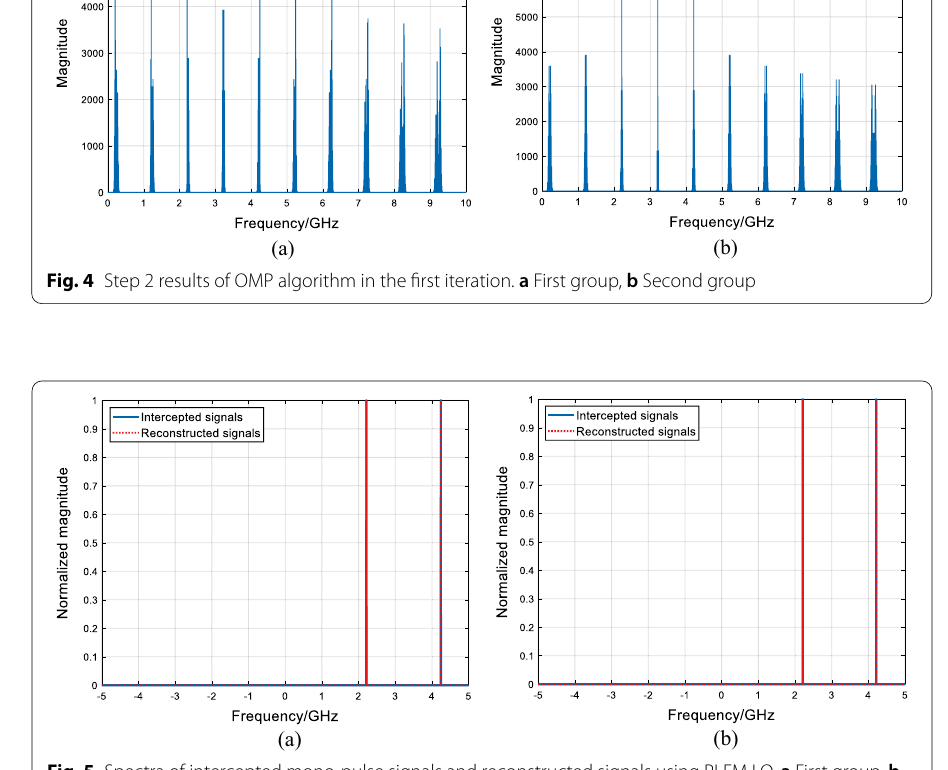
Fig. 5 Spectra of intercepted mono-pulse signals and reconstructed signals using PLFM LO. a First group, b Second